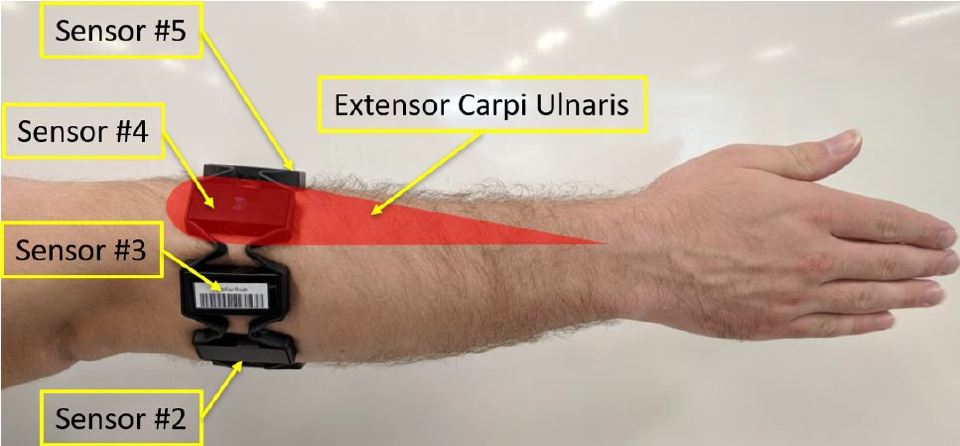
Figure 1. Placement of the Myo Armband on the user’s dominant arm. The IMU is located within Sensor